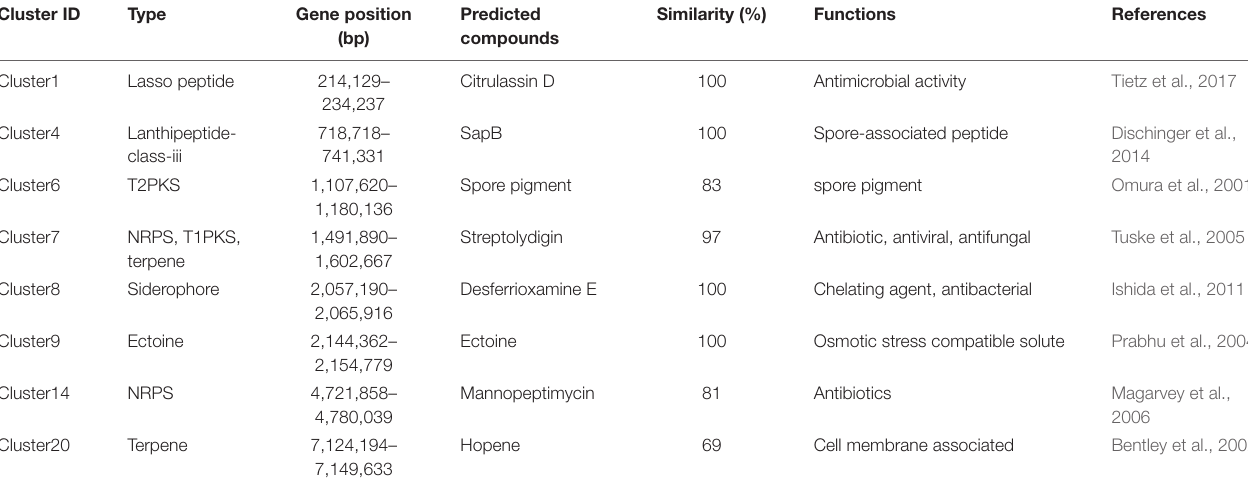
FIGURE 4 | Analysis of genome structure and metabolic pathway of S. lydicus M01. (A) CGView of S. lydicus M01 chromosome. From outside to center, rings 1 and 4 show protein-coding genes colored by COG categories on forward/reverse strand. Rings 2 and 3 show CDS, tRNA, and rRNA on forward/reverse strand. Ring 5 represents the G + C content. Ring 6 represents GC-Skew value. (B) COG annotation of S. lydicus M01 genome. (C) Pathway annotation of S. lydicus M01 genome according to the KEGG database. The vertical axis represents the level two classification of KEGG pathway. The horizontal axis represents the number of genes annotated in this classification. Different colors of the columns represent different level one classifications of KEGG pathway. TABLE 2 | Prediction and functional annotation of secondary metabolites from S. lydicus M01